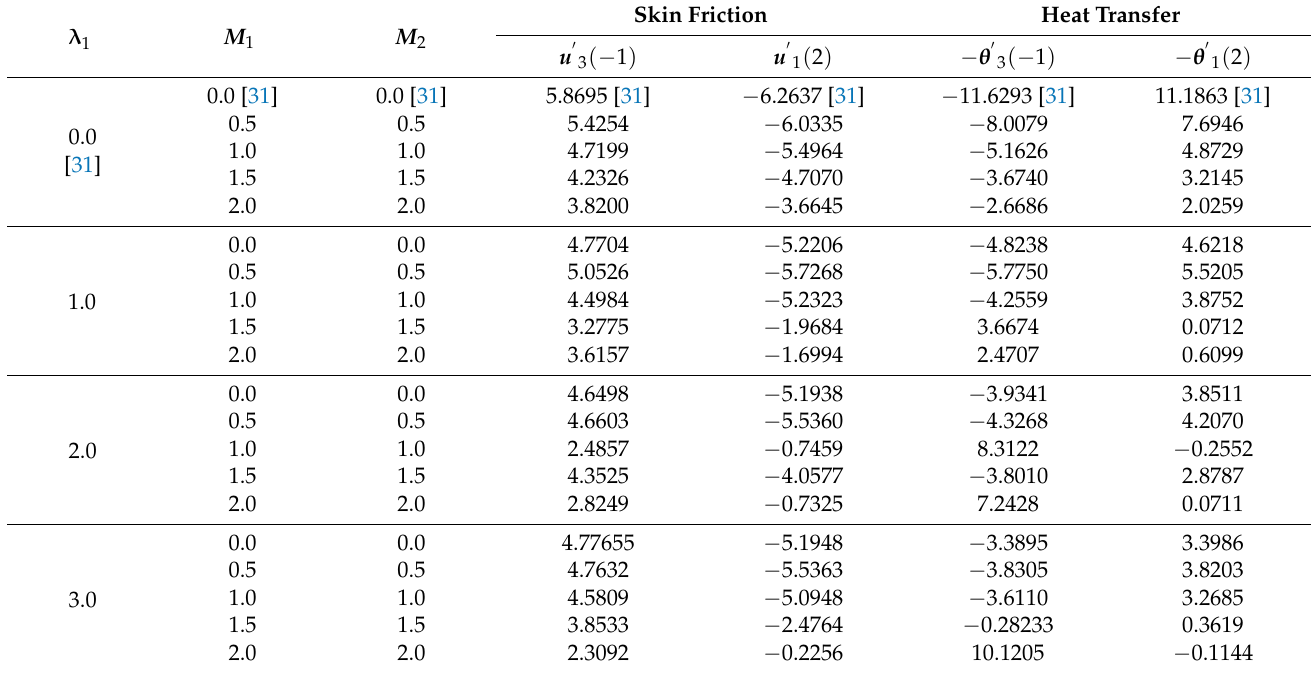
Table 1. Variation in skin friction and heat transfer values for different physical parameters at n =